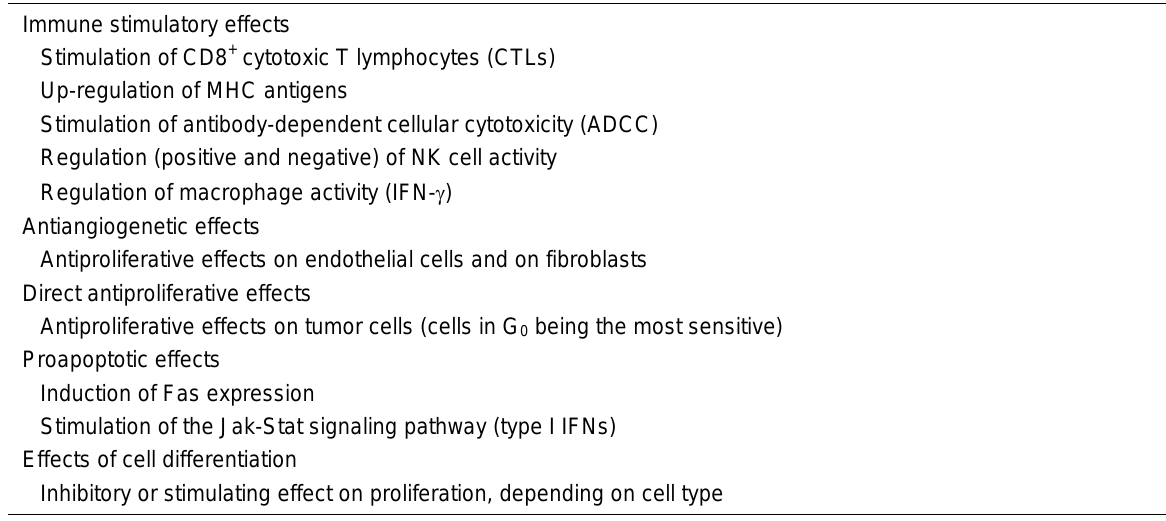
Biological Effects of IFNs Potentially Implicated in Their Antitumor